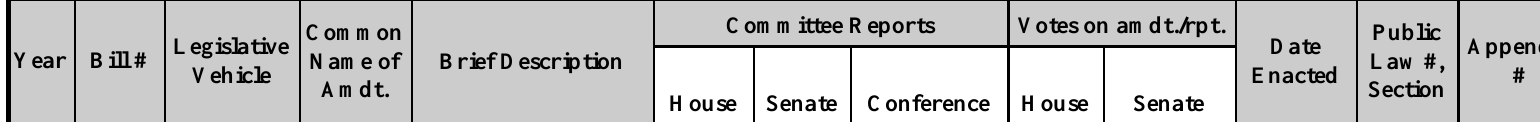
Table 1. Funding Restrictions on Military